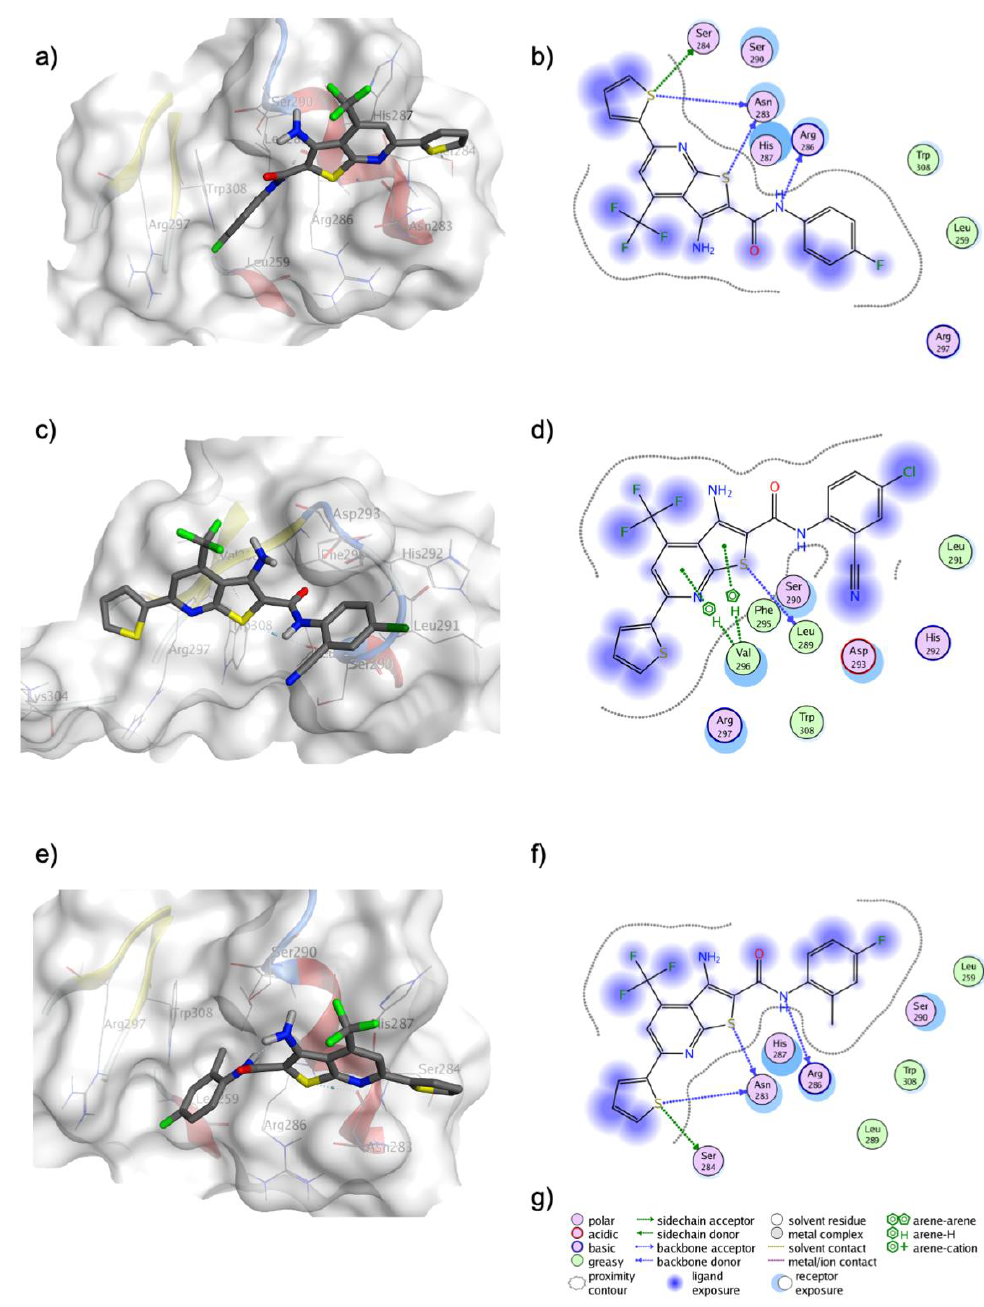
Figure 7. Docking poses and ligand interaction diagrams for compounds FDI-6 ; 1 , an example of an inactive compound; and 6 , an example of an active compound. ( a ) Docking pose of compound FDI-6 . ( b ) Ligand interaction diagram for compound FDI-6 . ( c ) Docking pose of compound 6 . ( d ) Ligand interaction diagram for compound 6 . ( e ) Docking pose of compound 1 . ( f ) Ligand interaction diagram for compound 1 . ( g ) Ligand interaction diagram legend.